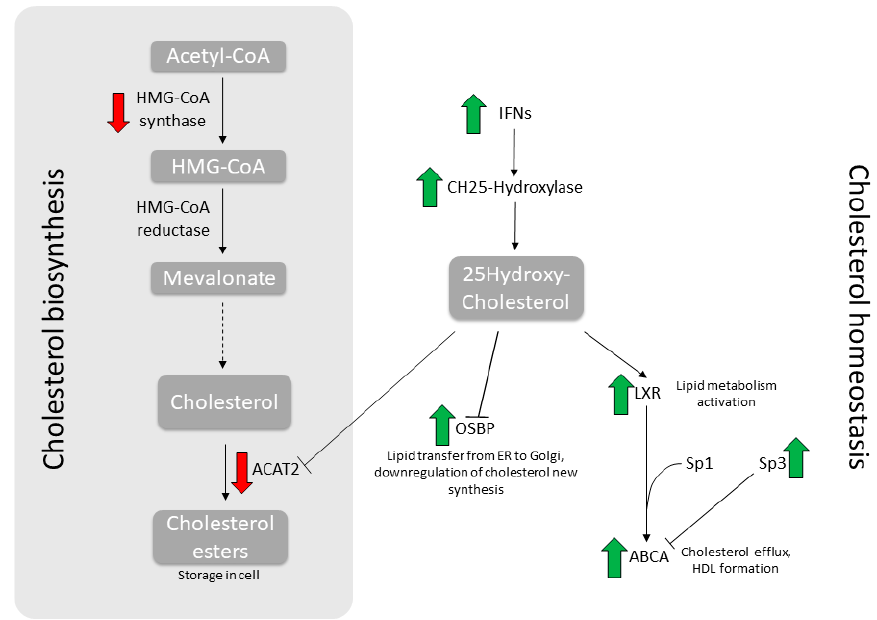
Figure 3. Synoptic summary of the main genes involved in cholesterol metabolism. Depicted here are the main metabolic steps in cholesterol biosynthesis ( left ) and homeostasis ( right ). Wide arrows indicate modulations induced by NTZ treatment.